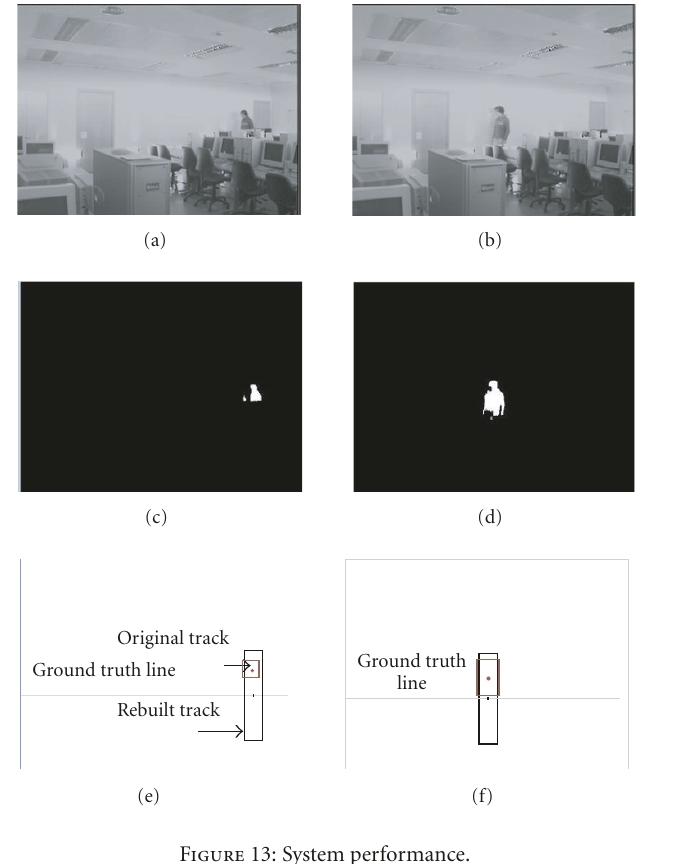
Figure 13: System performance.